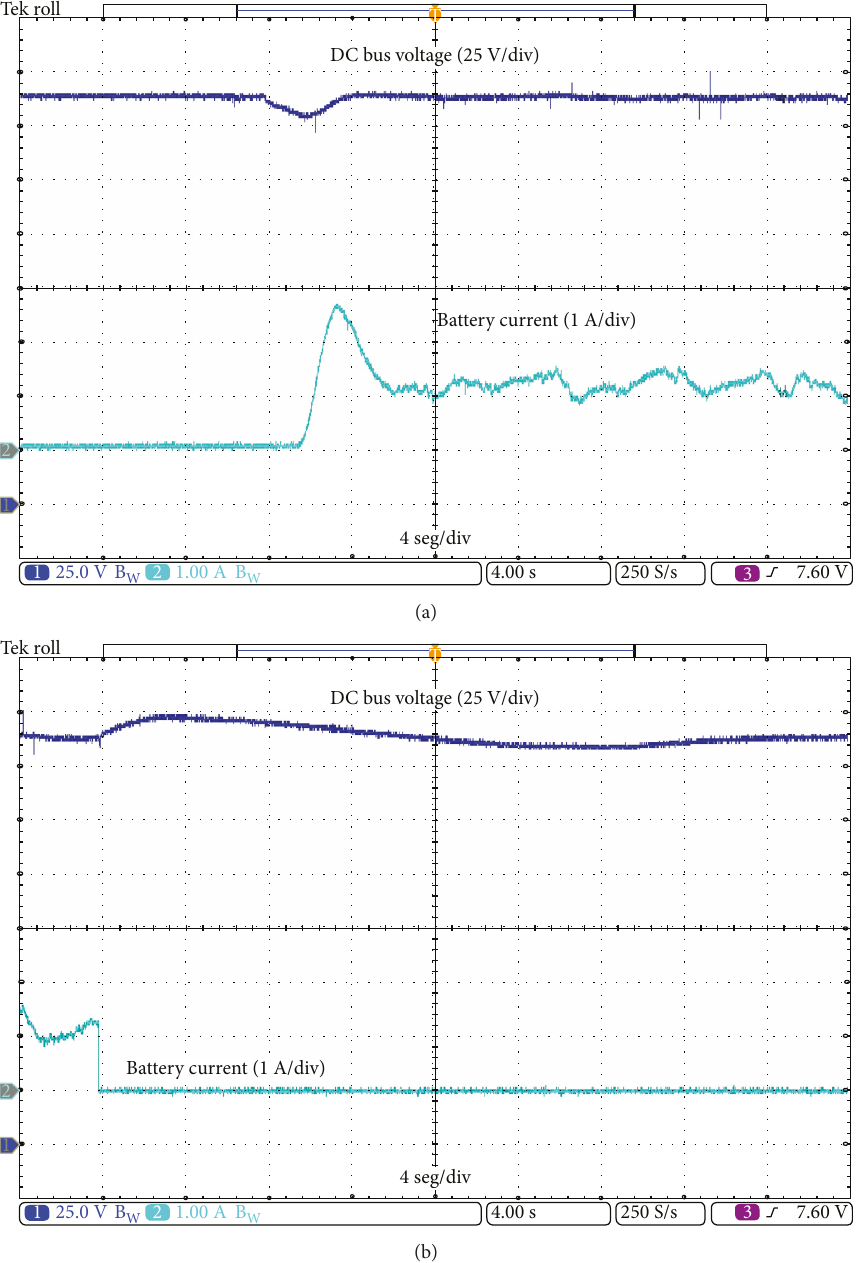
Figure 14: (a) Change of control mode for photovoltaic panels and the activation of the battery bank and (b) change of operational mode in the photovoltaic panels and battery